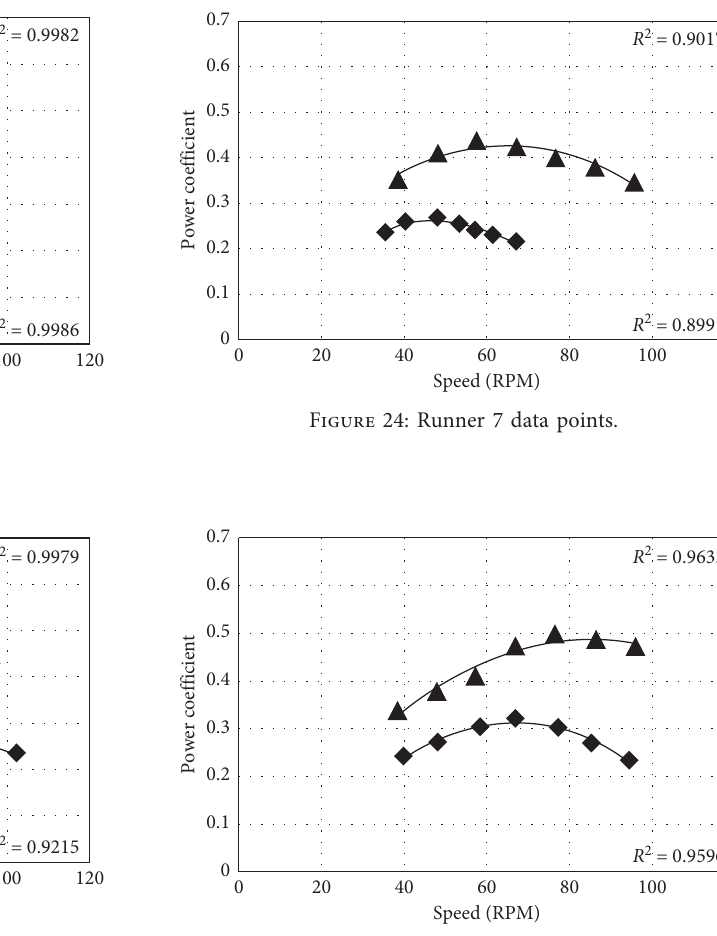
Figure 25: Runner 8 data points.